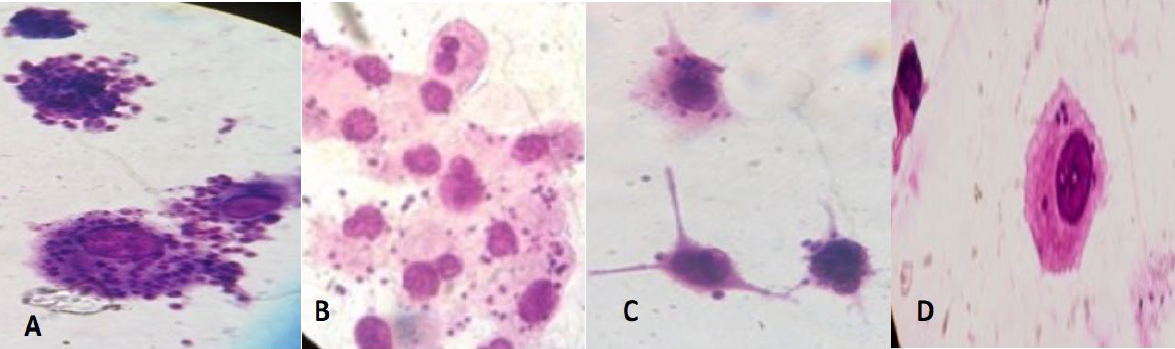
Figure 3. Giemsa stained THP-1 cells infected with Leishmania tropica 48 h post-infection and post- treatment with meglumine antimonate ( A ) Untreated control THP-1 ( B ) Treated with meglumine antimoniate ( C ) 10-hydroxy chondrofoline ( D ) Tafenoquine. 2.3. Testing In Vivo Leishmanicidal Activity Using BALB/c Mice Experimentally Infected